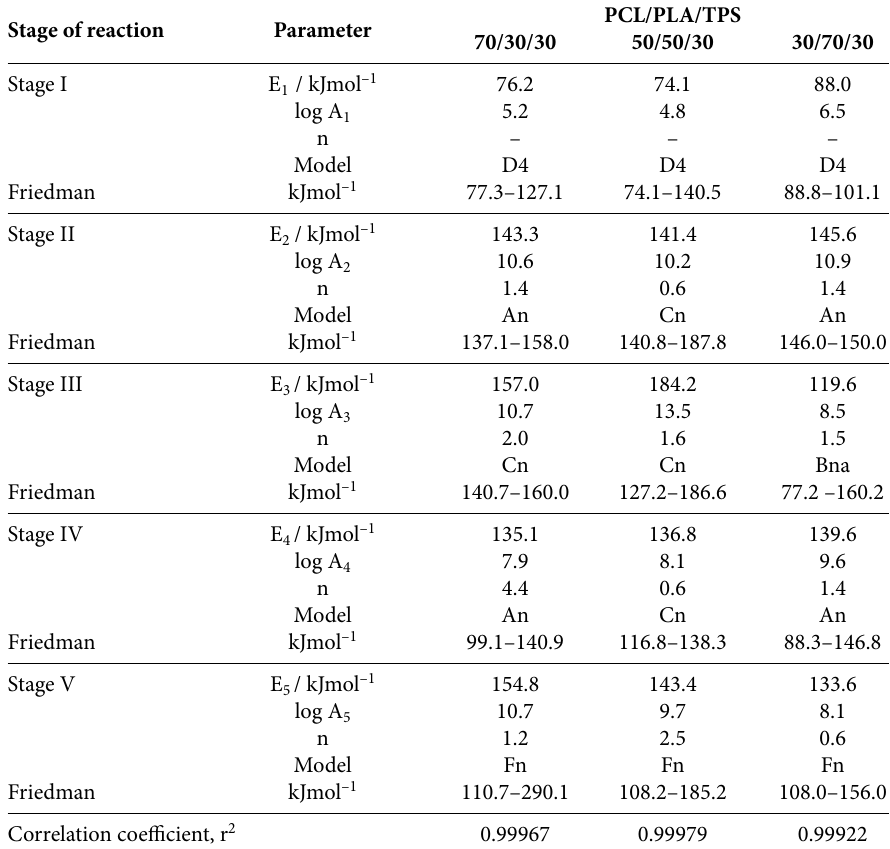
Table 6. The most probable kinetic models of thermal degradation of PCL/PLA/TPS blends according to F-test and correlation coefficient obtained by using multivariate non-linear regression analysis Stage of reaction